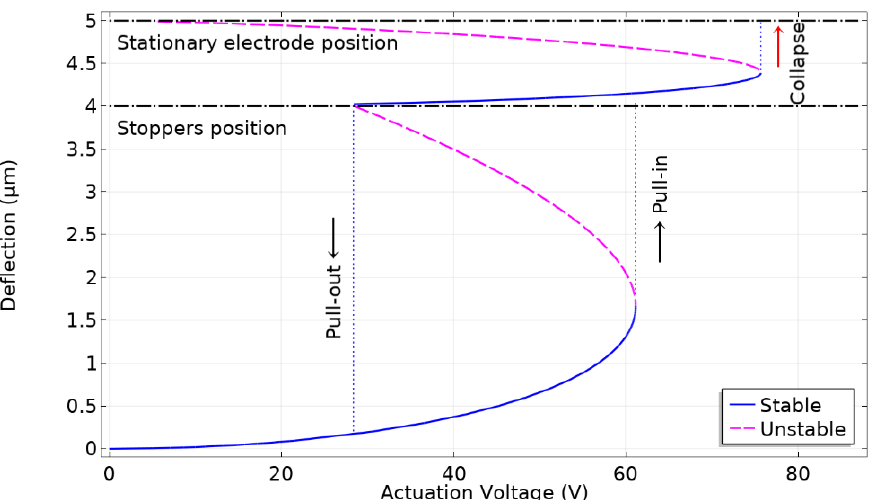
Figure 5. The static deflection-voltage curve for a 2D model of the AUC corresponding to Table 1 generated by simulation with COMSOL. It shows the stable and unstable regions of the curve as well as the major transitional points, namely, the pull-in, pull-out, and collapse transitions. The dot-dashed lines represent the positions of the stoppers and the stationary electrode.